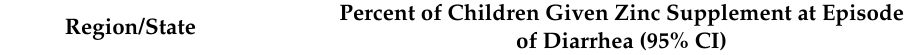
Table A2. Percentage of children with diarrhea during the 2 weeks prior to the survey that were reported to have received zinc in the 2018 NDH by Regions and